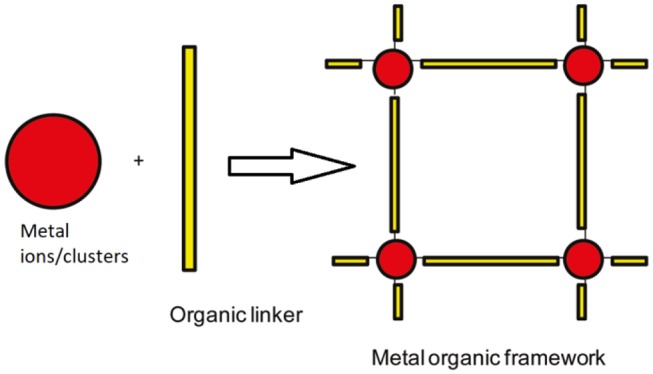
Formation of MOFs.